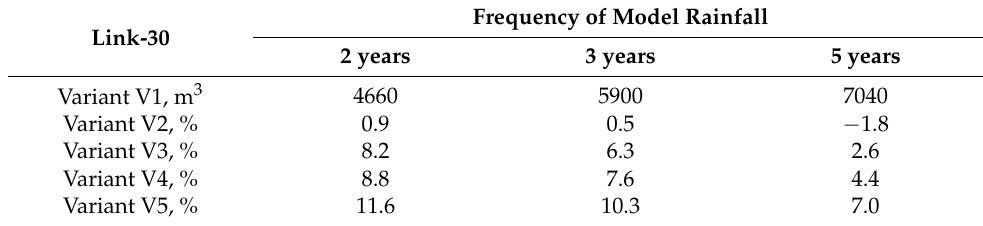
Table 7. Reduction of runoff volume in relation to the base variant—Link 39 calculation segment.